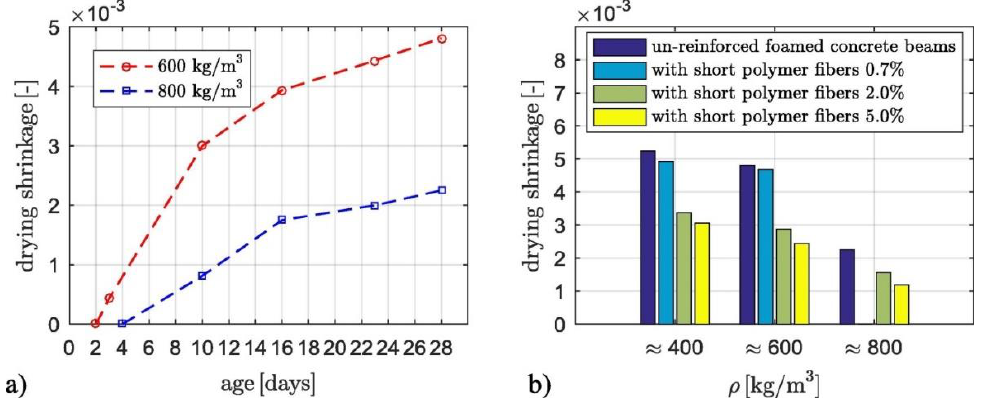
Figure 6. Evaluation of FC drying shrinkage ( a ) without fibres and ( b ) with fibres. Reprinted with permission from publisher (2020) [23].